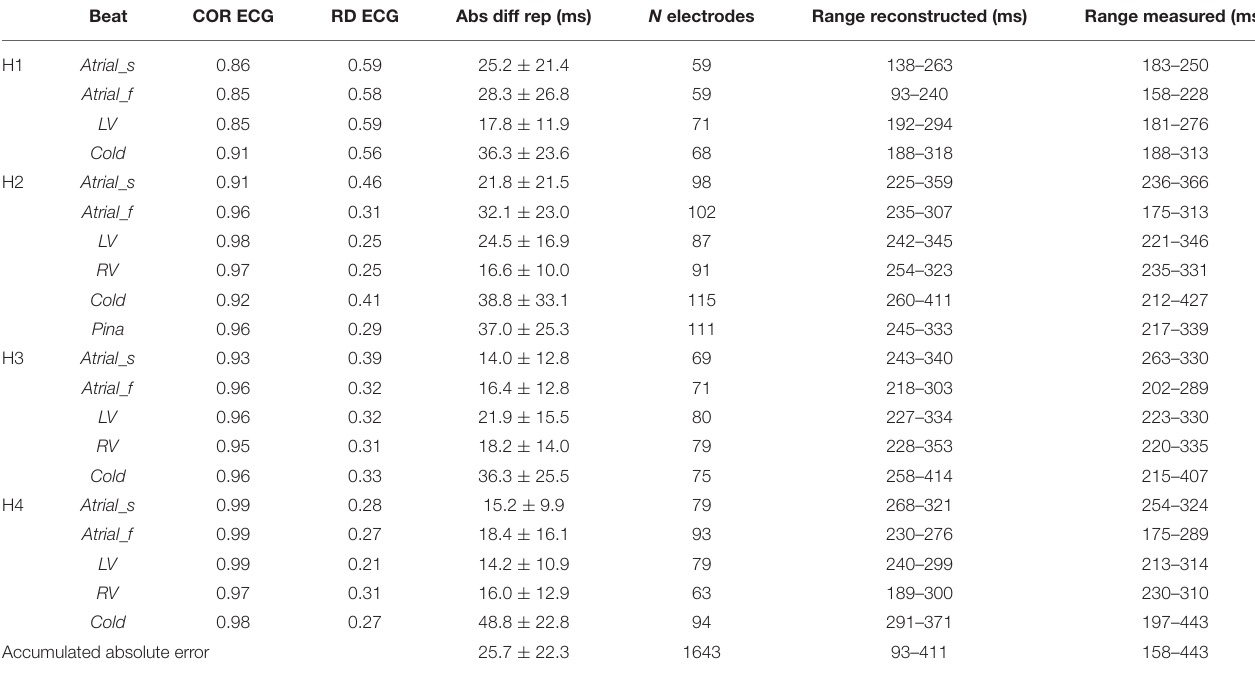
TABLE 1 | Comparison of the parameters between the reconstructed and measured pseudo-ECGs and the repolarization times for different conditions per heart (H1 to H4). Beat COR ECG RD ECG Abs diff rep (ms) N electrodes Range reconstructed (ms) Range measured